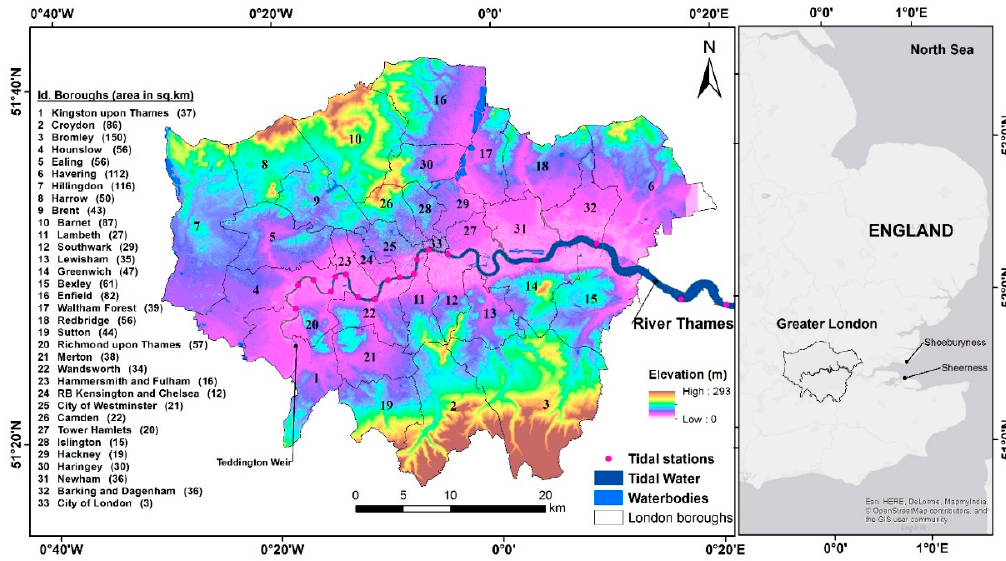
Figure 1. ( left ) the boroughs that constitute Greater London and Greater London’s ( right ) location within southern England and. The topographical (LiDAR) elevation (m), the River Thames, Greater London boroughs with area (km 2 ), and locations mentioned in the text are labelled.